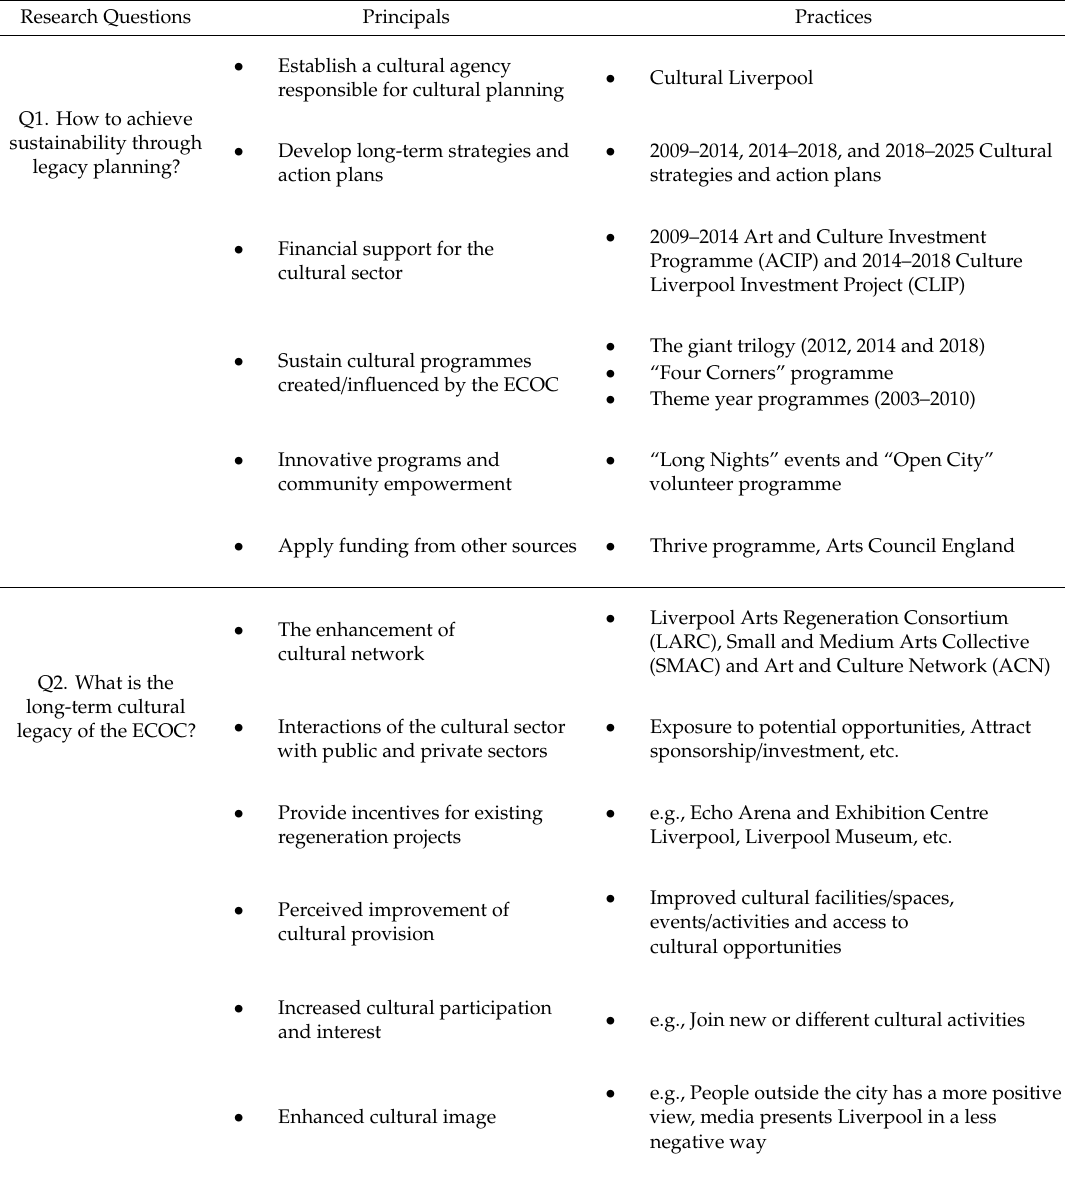
Table 1. Summary of lessons learned from